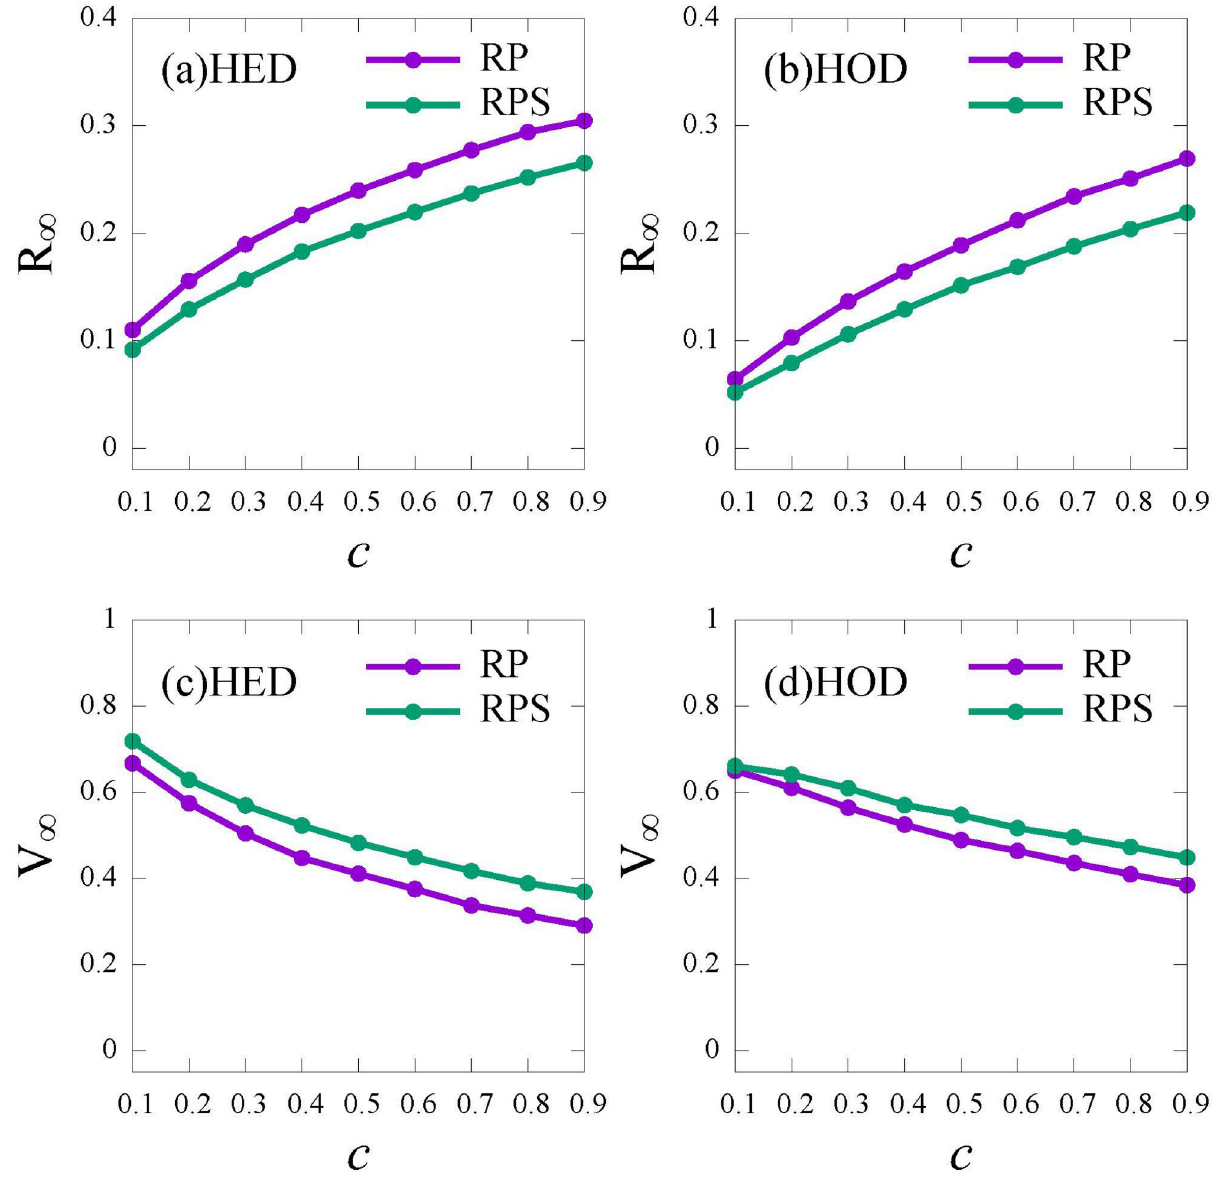
Fig 5. The final epidemic size ( R 1 ) and the vaccine coverage ( V 1 ) versus c under the RP and the RPS strategies. Risk perception vaccination strategy (RP, purple); Risk perception with subsidy policy vaccination strategy (RPS, green). (a) and (c): HED network; (b) and (d): HOD network. Here, the infection rate λ =